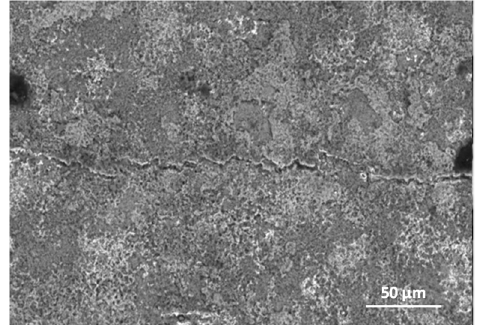
Figure 7. SEM micrograph of Ti-46Al-7Nb-0.7Cr-0.1Si-0.2Ni alloy exposed to air at 875 °C—surface prepared by grinding (fragmentary chipping of products).